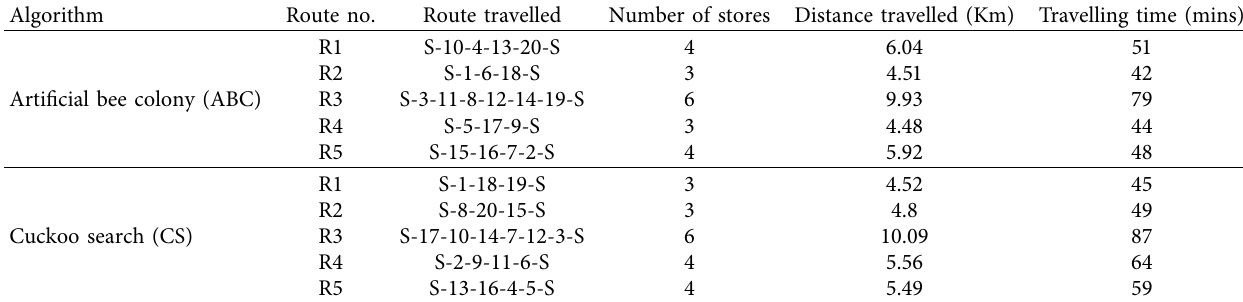
Table 1: 20 delivery locations with 5 delivery vehicles.